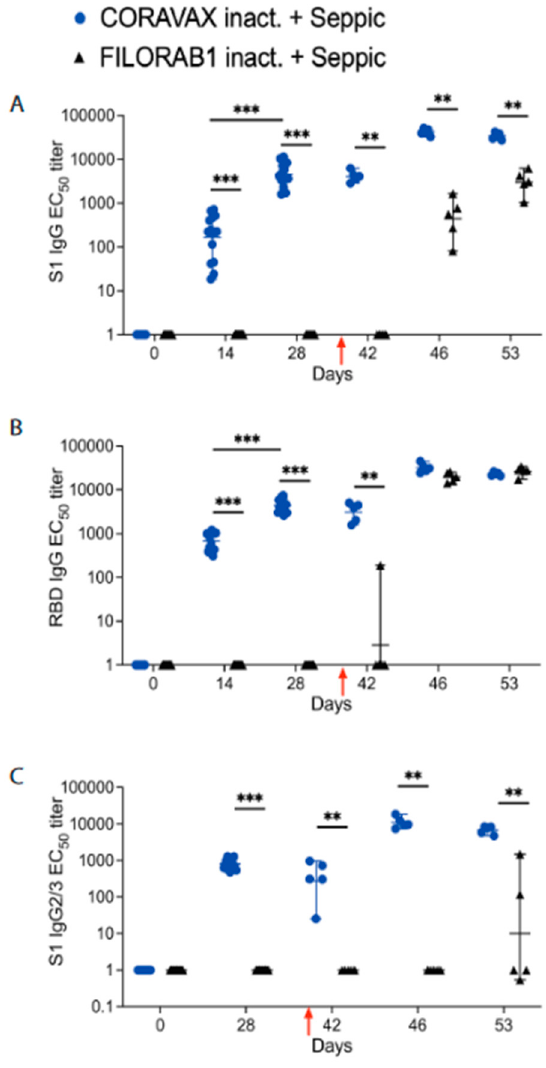
Figure 2. SARS-CoV-2 immune responses. Serum samples collected from each hamster were evaluated for SARS-CoV-2 S-specific immune responses by ( A ) ELISA, anti-SARS-CoV-2 S1 IgG responses represented as EC50 titers over time, ( B ) ELISA, anti-SARS-CoV-2 RBD responses, and ( C ), ELISA, anti-SARS-CoV-2 S1 IgG2/3 responses. The CORAVAX vaccine group is shown in blue circles, and the FILORAB1 group is in black triangles. For ( A – C ), mean titers ± SD are depicted for each group per time point, and p values were determined by Mann–Whitney test. Only significant differences are depicted. p values are defined as: p > 0.123 (ns), p < 0.033 (*), p < 0.002 (**), p < 0.001 (***). Red arrow indicates the day of challenge (day 39).